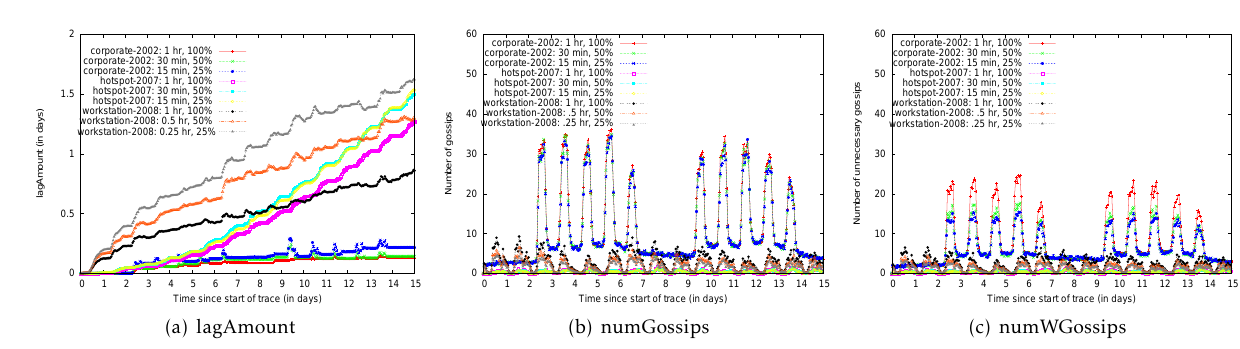
Figure 17. Tradeoff between update frequency and choosing fewer online nodes (group size: 15, P2P-pull )